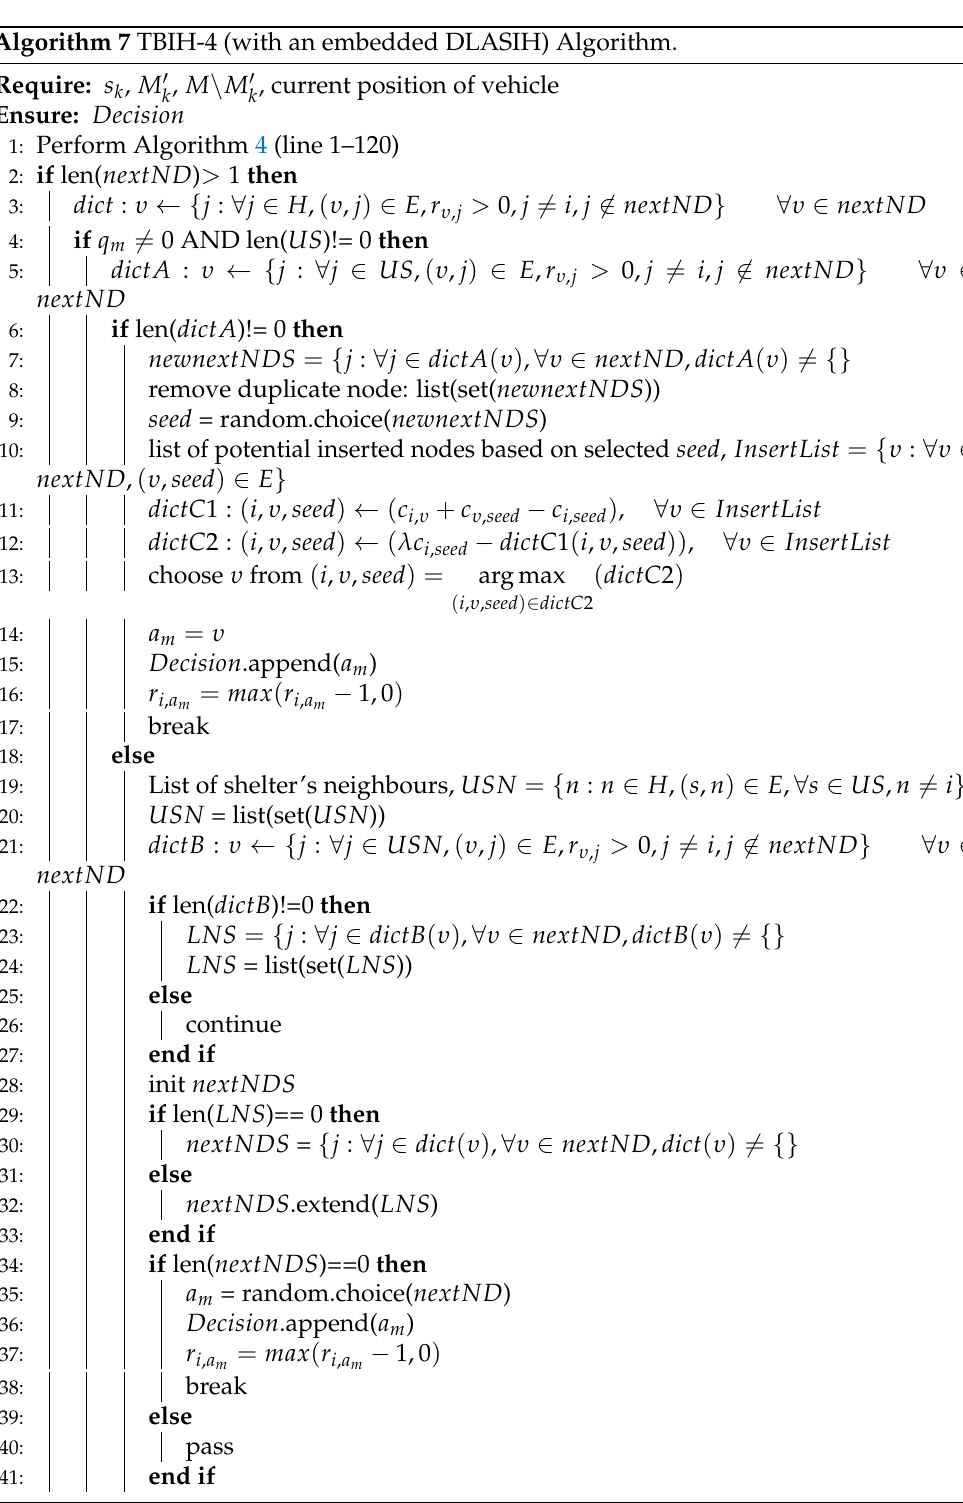
Algorithm 7 TBIH-4 (with an embedded DLASIH)